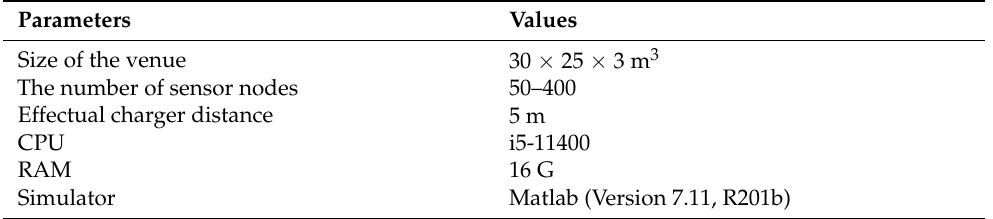
Table 1. Simulation parameters.